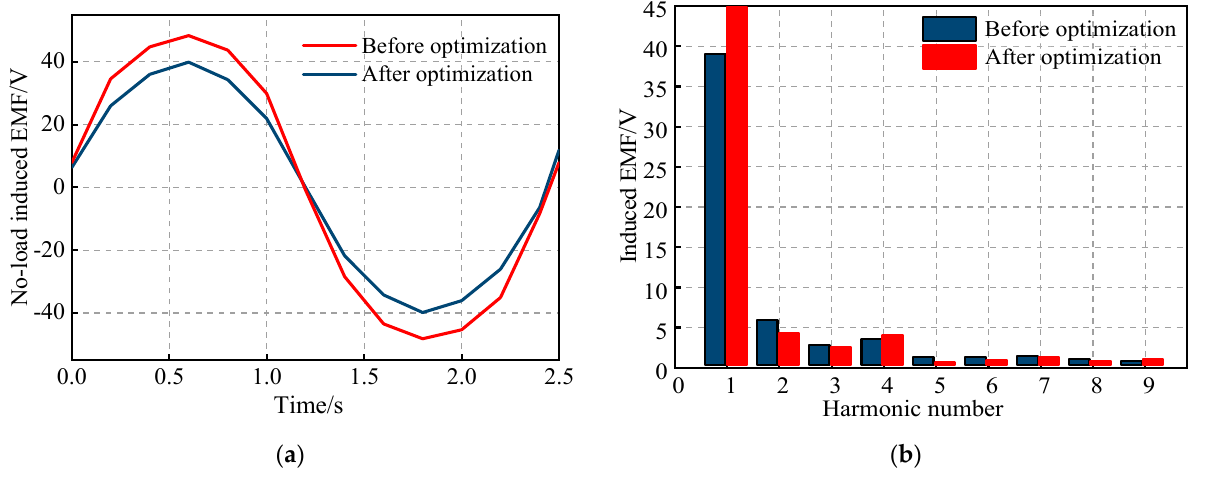
Figure 21. Comparison of induced EMF of the generator before and after optimization. ( a ) Comparison of induced EMF curves; ( b ) comparison of induced EMF harmonic distribution.